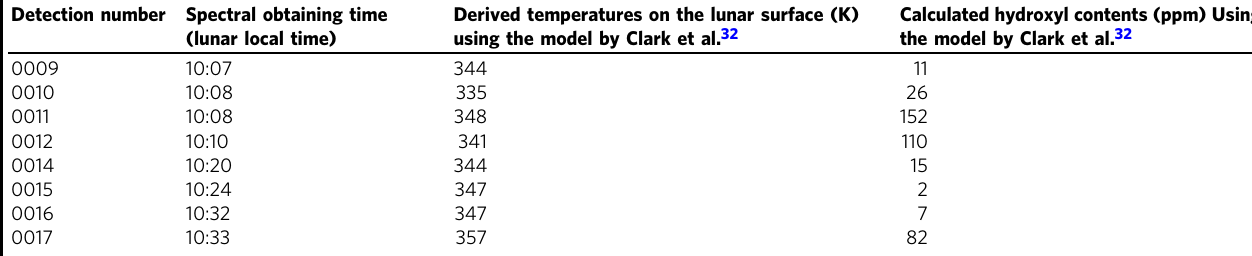
Calculated hydroxyl contents (ppm) Using the model by Clark et al.